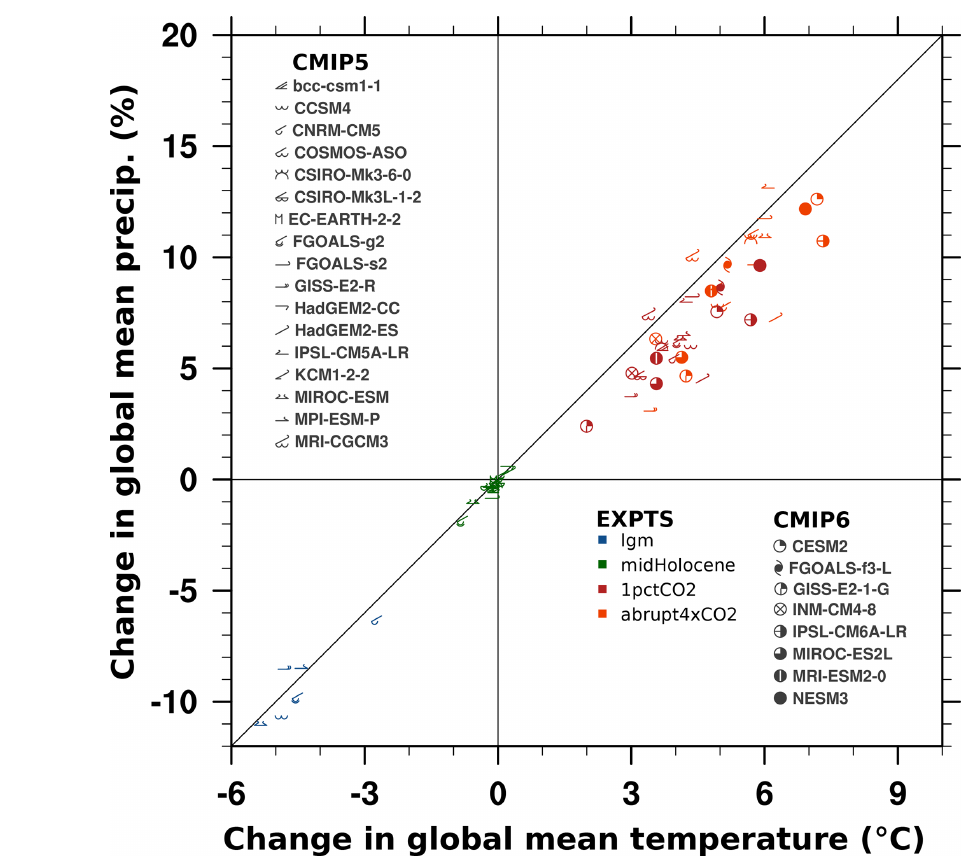
Figure 1. Hydrological sensitivity across the past and future model ensemble. The change in global mean temperature from the PI is plotted against the percentage of change in the global mean precipitation rate. Symbols indicate the different climate models, following Table 1. Colors show the different experiments. The line indicates a 2% change in precipitation per Kelvin temperature